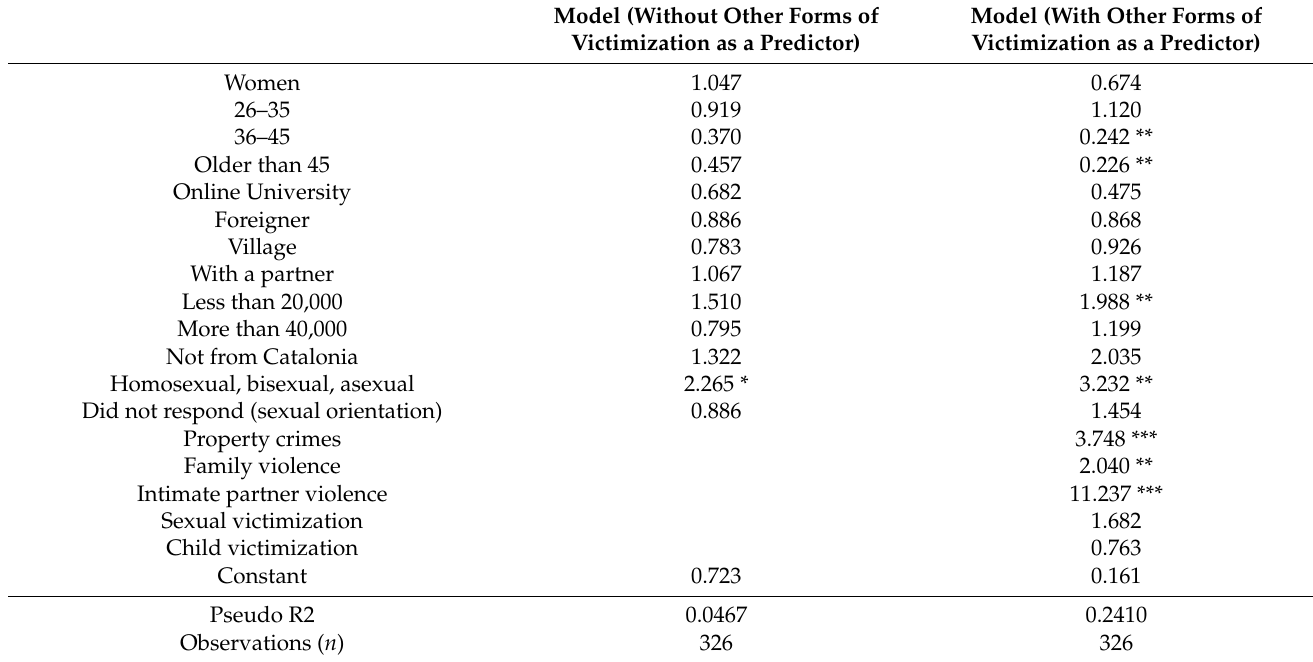
Table 5. Logistic regression for class 2 (cyber-polyvictimization) ( n = 127). Model (Without Other Forms of Victimization as a